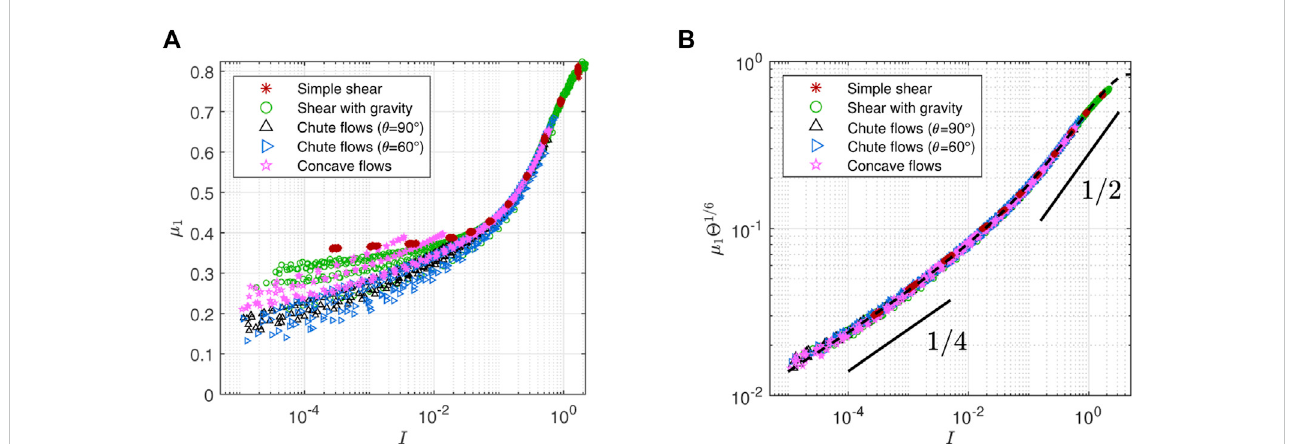
FIGURE 4 (A) Shear stress to pressure ratio μ 1 = | σ xz |/ P vs. inertial number I . Scattered data indicate μ 1 is not a function of I alone. (B) Rescaling μ 1 by the dimensionless temperature to the power of 1/6 makes scattered points collapse into a master curve: μ 1 Θ 1/6 = f 1 ( I ). Dashed trend line is f 1 ( I ) used for the FDM simulations in Section 3.